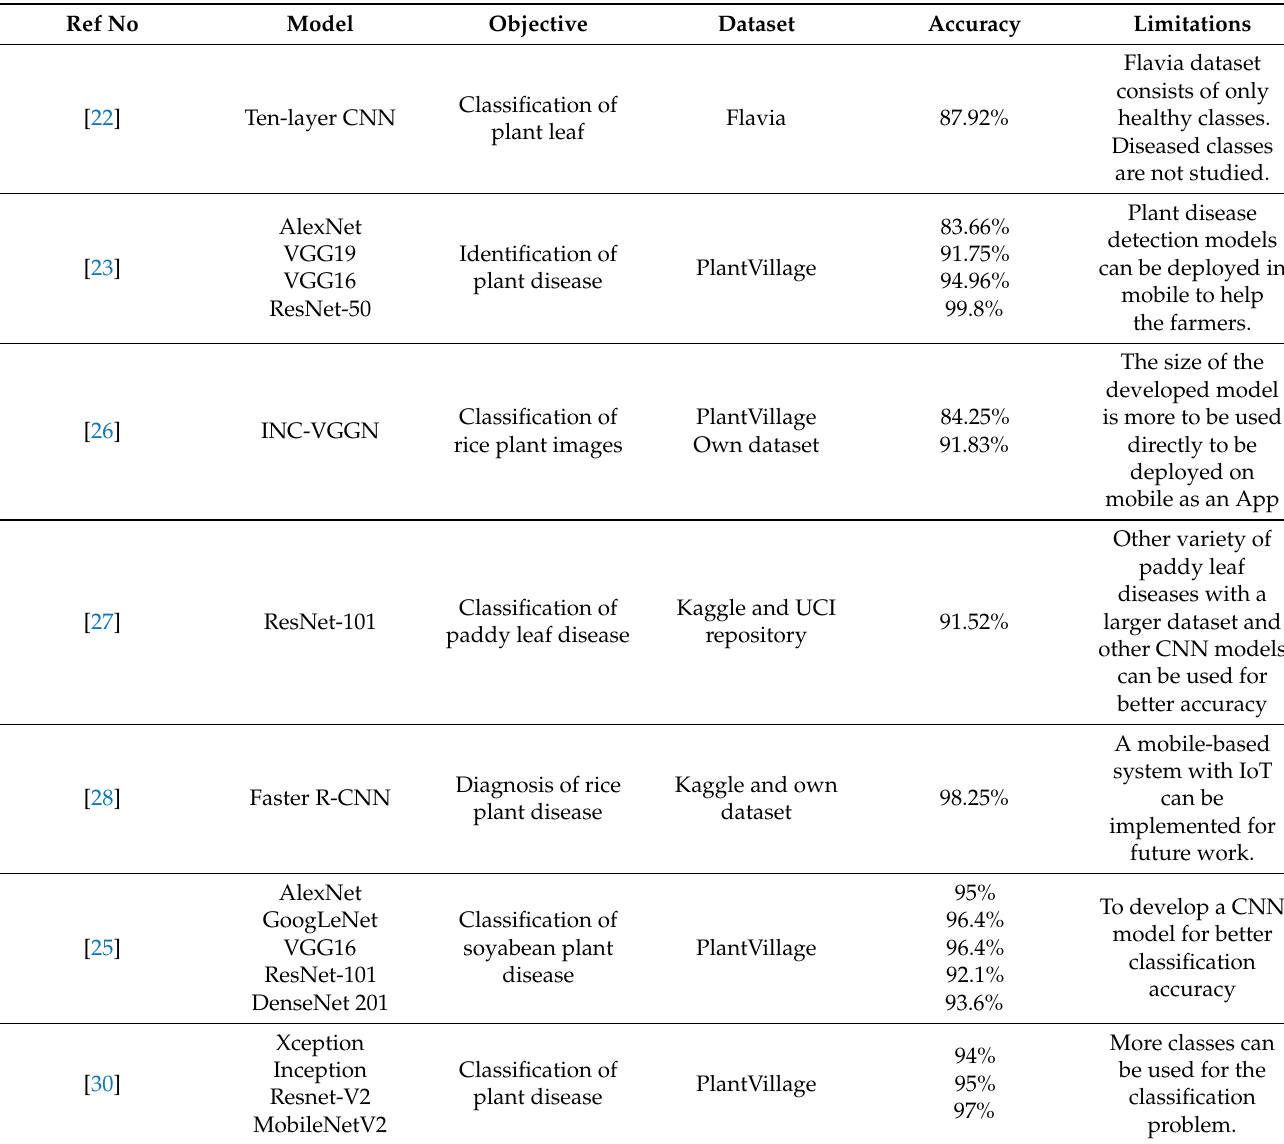
Table 1. Comparative study of related work in classification of plant disease. Ref No Model